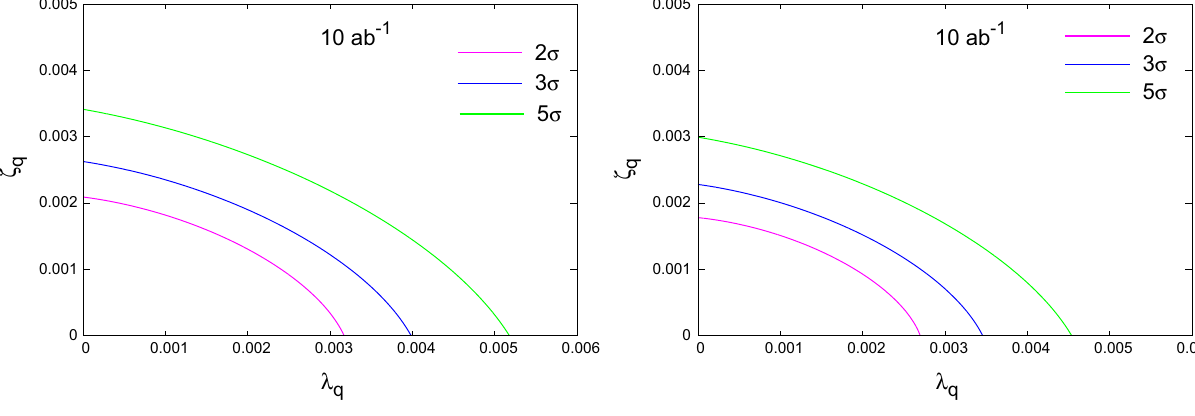
Fig. 7 The contour plots of 2 σ , 3 σ and 5 σ significance on the λ q - ζ q anomalous FCNC couplings plane with an integrated luminosity of 10 ab − 1 for leptonic (on the left) and hadronic (on the right)